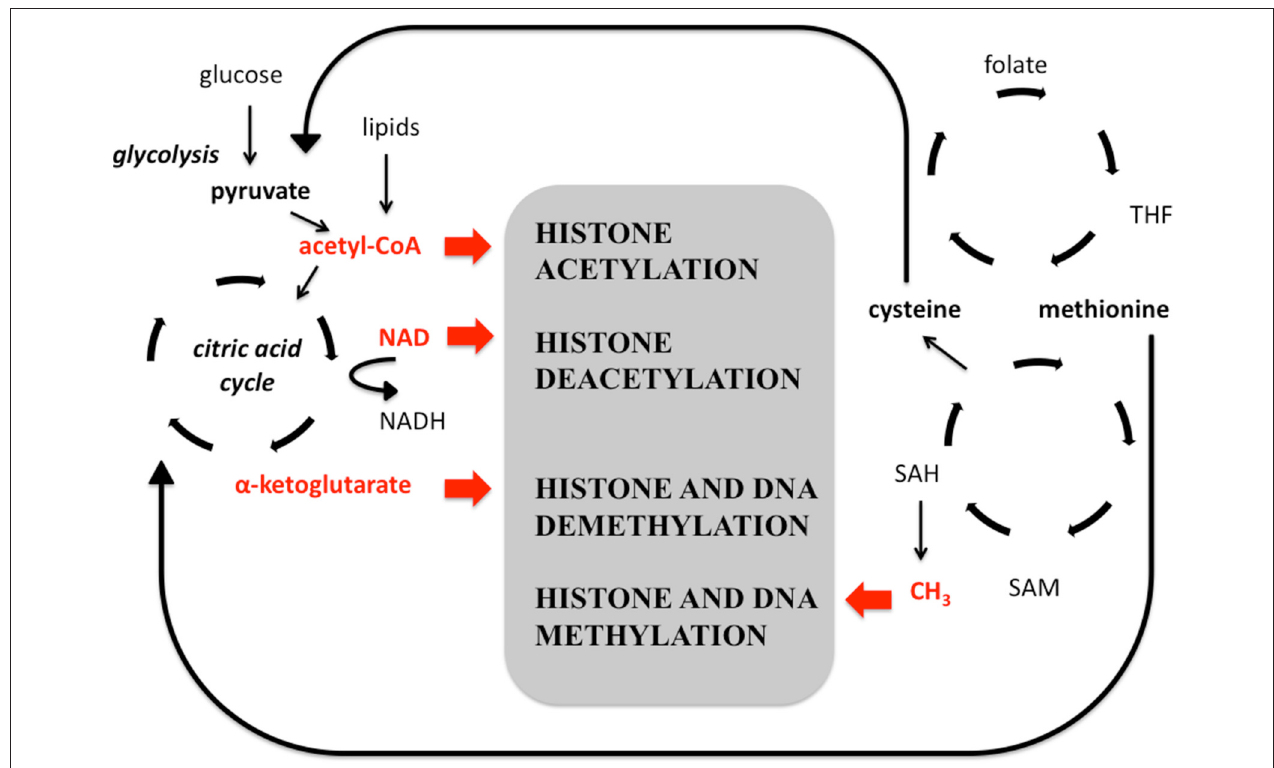
FIGURE 2 | The relationship between epigenetic modifications and intermediary metabolism. Glycolysis, lipid metabolism, citric acid cycle, amino acid metabolism, and folate/SAM cycles are tightly linked to epigenetic modifications (shown in the middle), since their products and cofactors (shown in red) are substrates of enzymes catalyzing the epigenetic modifications. Acetyl-coenzyme A and NAD contribute to histone acetylation and deacetylation, respectively. Methyl groups and alfa-ketoglutarate participate in the methylation and demethylation of both histones and DNA. NAD: nicotinamide adenine dinucleotide, THF: tetrahydrofolate, SAH: S-adenosylhomocysteine, SAM: